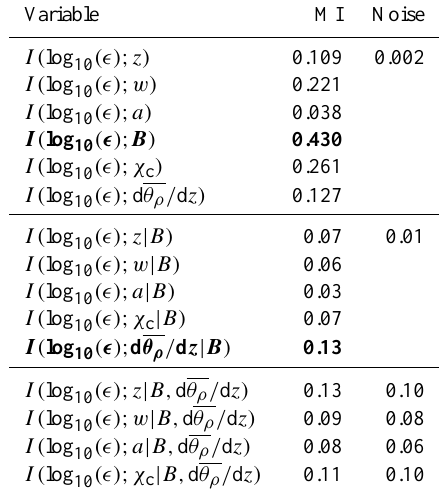
Table 2. Mutual information between log 10 ((cid:15)) and various cloud core properties for individual clouds in the combined BOMEX and ARM LES output. Noise level is found by taking the maximum of 100 Monte Carlo trials of mutual information between log 10 ((cid:15)) and a random permutation of each variable. Maximum mutual informa- tion values in each comparison category are in